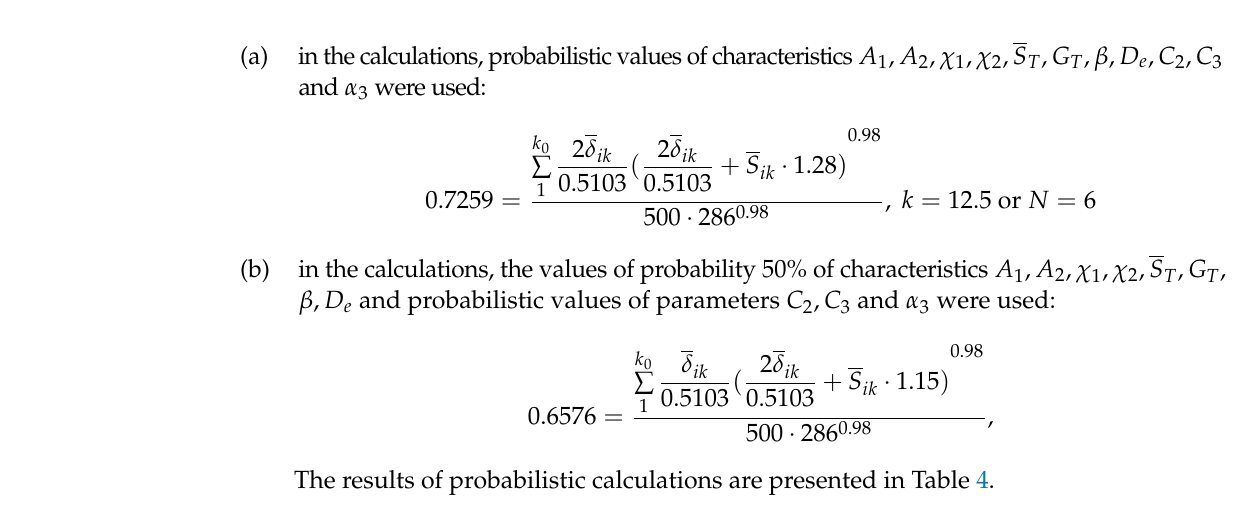
Table 4. Results of probabilistic calculation of life in the concentration